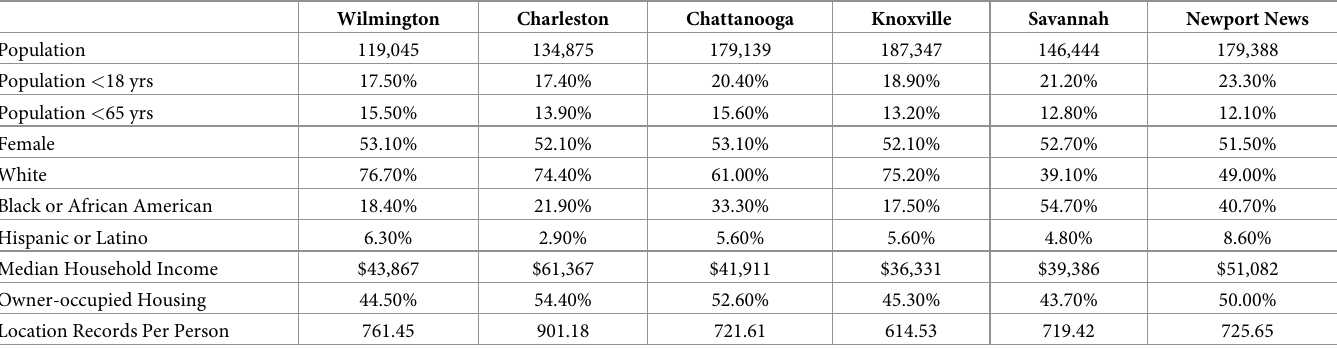
Table 1. Demographics of the six cities under